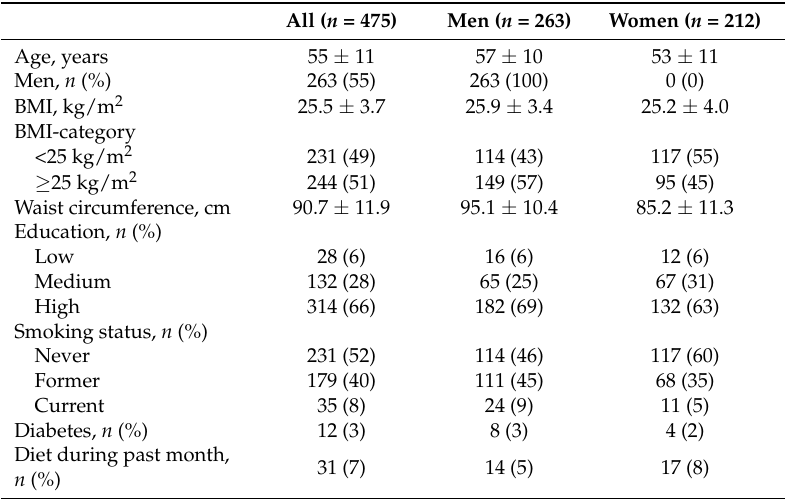
Table 1. General characteristics of the study population included in the glycaemic index FFQ (GI-FFQ) validation study 1